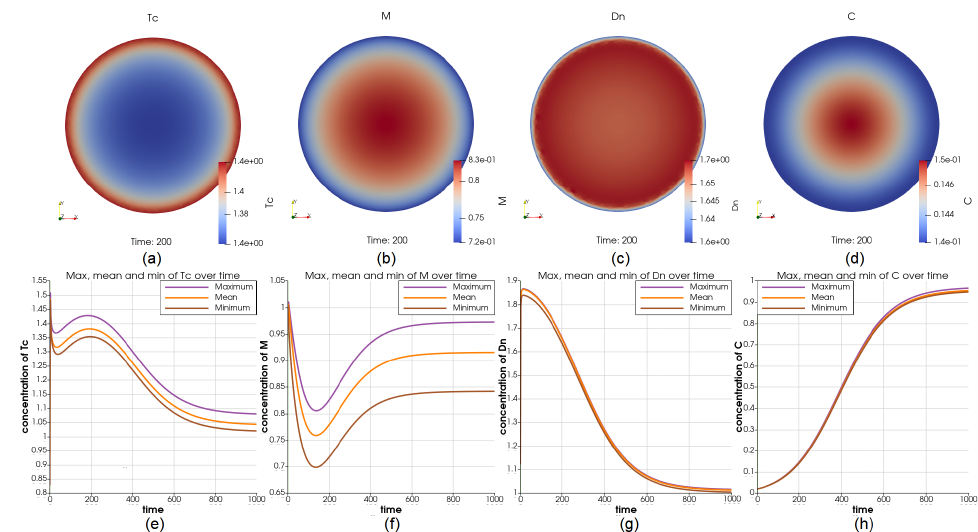
Figure 6. Illustrations for the case of using Robin boundary condition for 5 immune cell types. Sub- figure ( a – d ) show the value of T c , M , D n , and C at t = 200; Sub-figure ( e – h ) show the maximum and minimum in the whole interval for T c , M , D n , and C , respectively. Using the same boundary condition for 5 immune cell types results in different profiles for these cell types.